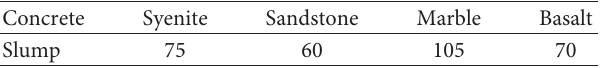
Table 10: Slump workability of concrete made of different ag- gregate types